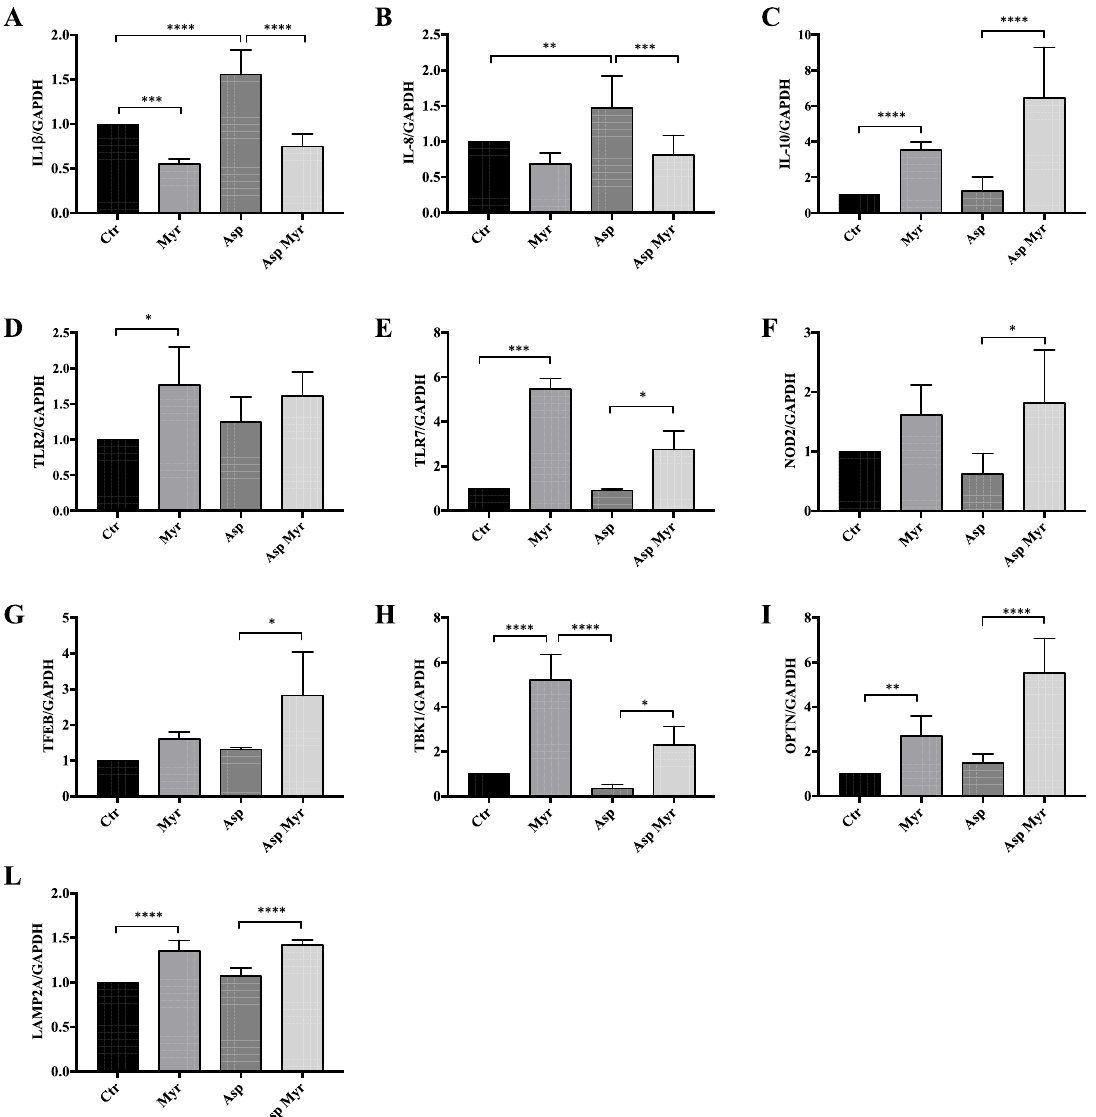
Figure 8. Quantification of the expression of genes involved in inflammation, response to infection, and autophagy: ( A ) pro-inflammatory IL1 β interleukin; ( B ) pro-inflammatory IL-8 chemokine; ( C ) anti-inflammatory IL10 interleukin; ( D – F ) pathogen recognition receptors (PRRs): NOD2 , TLR2 , and TLR7 ; ( G ) TFEB ; ( H ) TBK1 ; (I) OPTN ; ( L ) LAMP2a by qRT-PCR in A. fumigatus -infected and uninfected CF cells, treated and untreated with Myr (12 h after infection). GAPDH was used as a housekeeping gene. Data, derived for triplicate samples, are expressed as mean ± SE (* p < 0.05; ** p < 0.01; *** p < 0.001; **** p < 0.0001); two-way ANOVA followed by Bonferroni correction was used for all